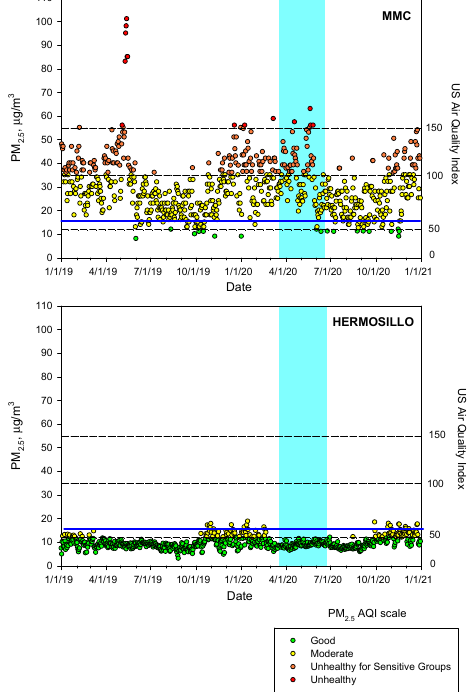
Figure 3. Time-series of maxima PM 2.5 24-h averages at MMC and daily means of PM 2.5 in Hermosillo from 1 January 2019 to 31 December 2020 following the US EPA AQI index. The blue continuous line depicts the revised 24-h average guideline of the WHO. The blue shade area represents the official lockdown COVID-period in Mexico. Air quality data are available from Sistema de Monitoreo Atmosferico